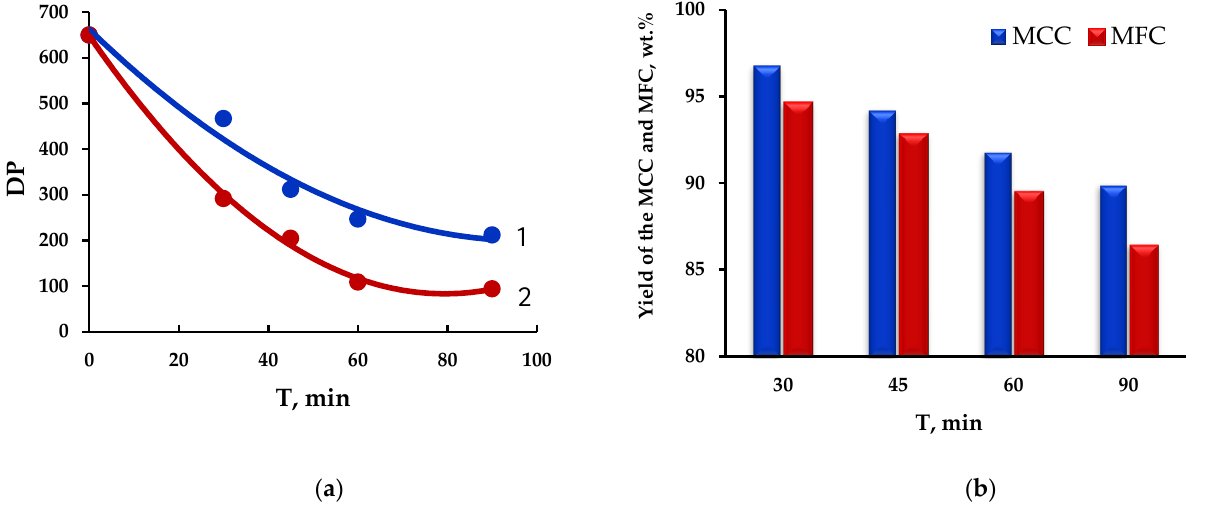
Figure 3. Effect of hydrolysis time: ( a ) on the change in DP 1–MCC; 2–MFC and ( b ) yield of MCC and